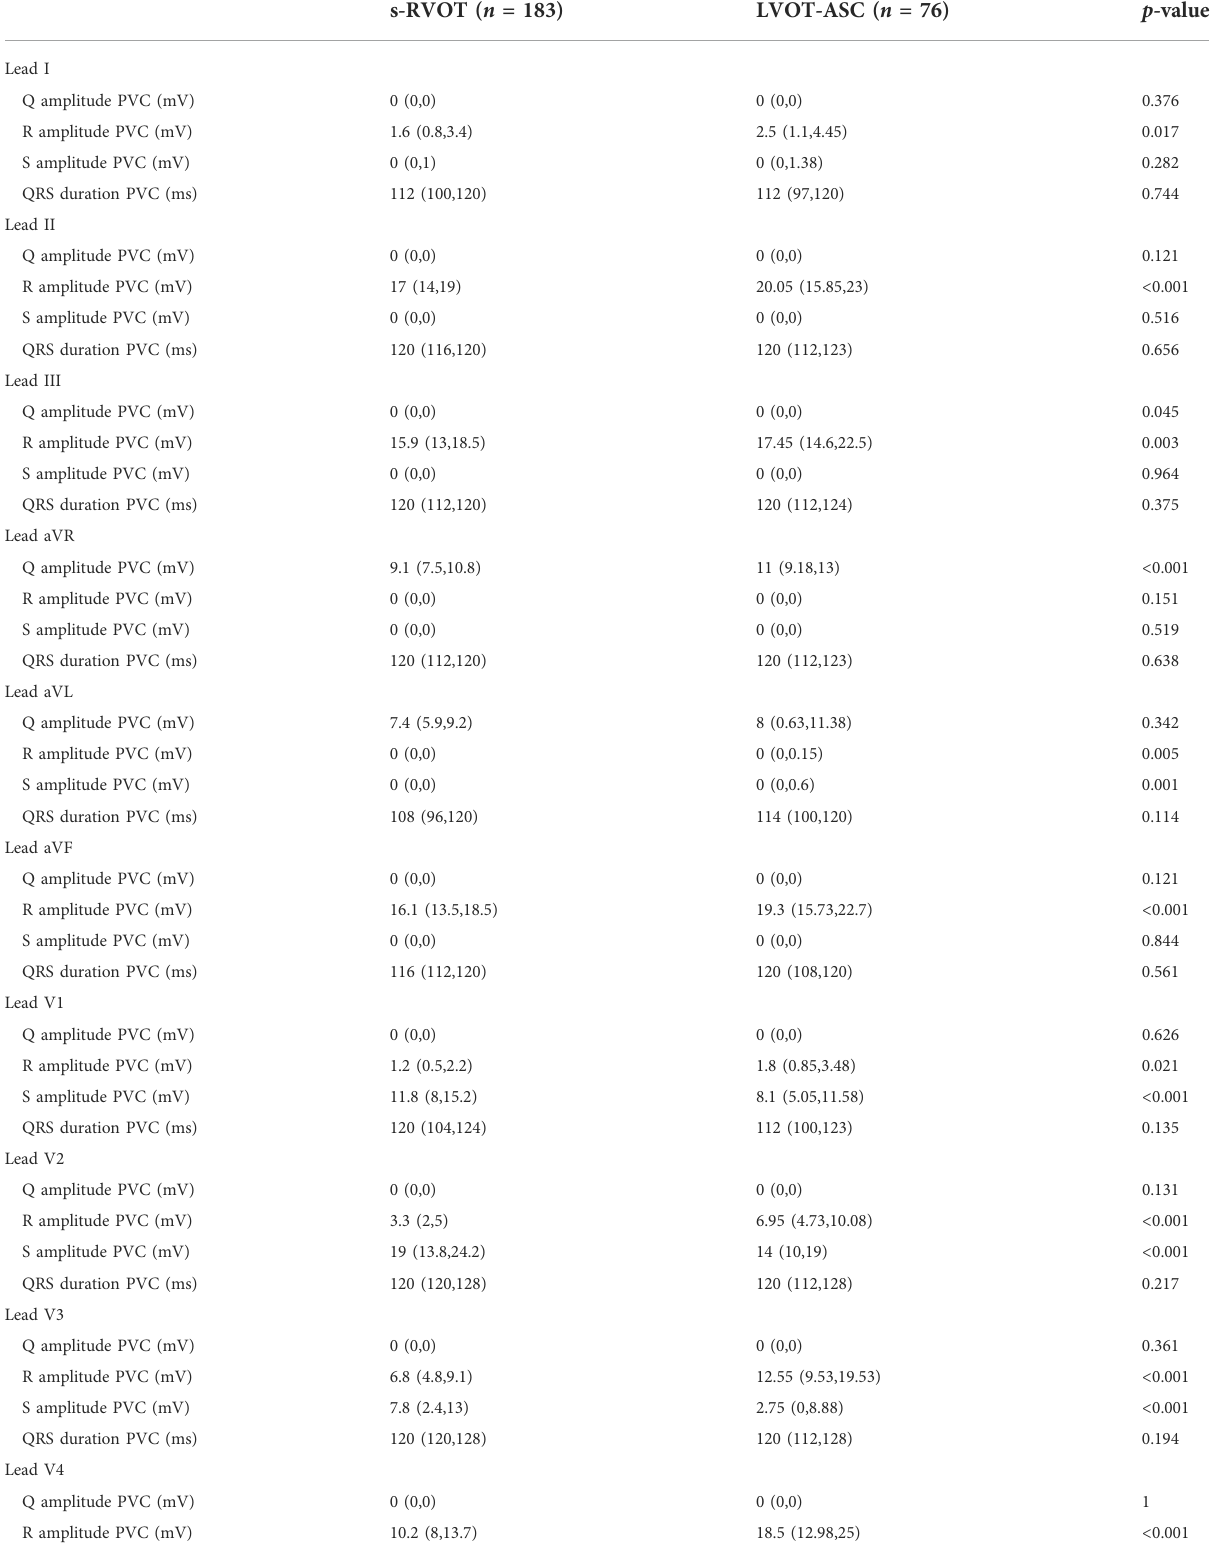
TABLE 2 Comparison of the electrocardiographic measurements of the s-RVOT and LVOT-ASC